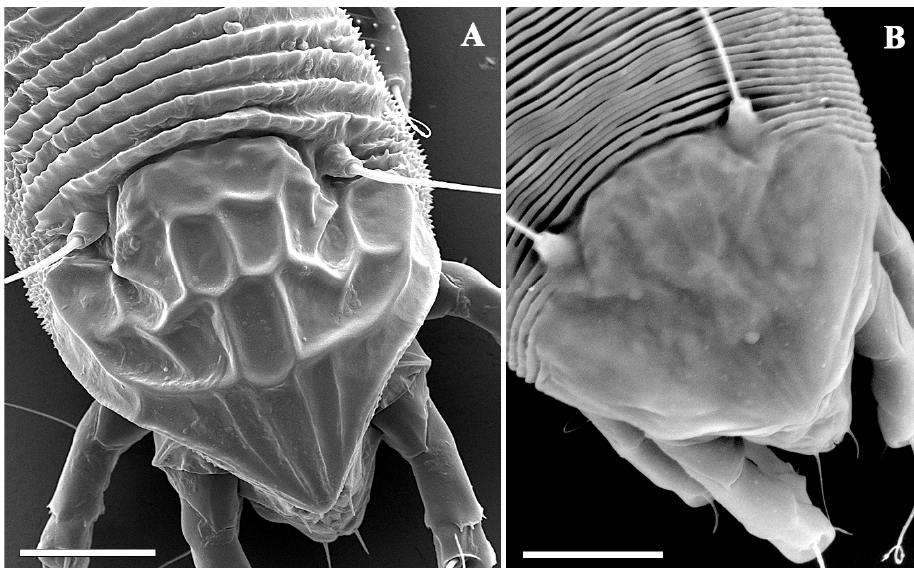
Figure 2. Scanning electron micrographs of deutogynes of Aculus mosoniensis : ( A ) dorsal view; ( B ) leg tarsal empodium and solenidion; ( C ) coxigenital region; ( D ) dorsal view of gnathosoma and frontal lobe. Scale bars: 10 μ m for ( A , B , D ); 2 μ m for ( B ).